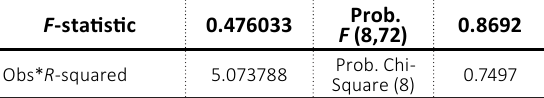
Table 4. Breusch-Godfrey serial correlation LM test